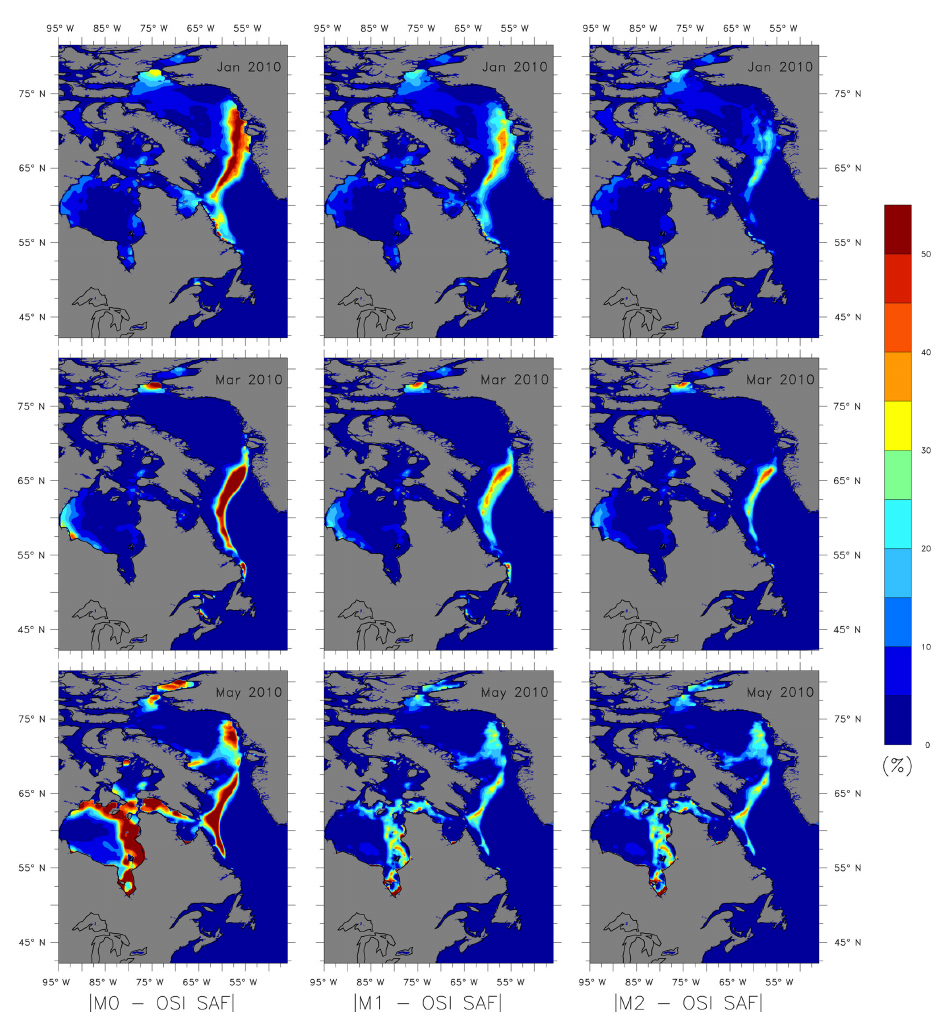
Figure 3. The absolute mean difference in ice concentration from non-assimilated, assimilated models and OSI SAF data for January, March and May